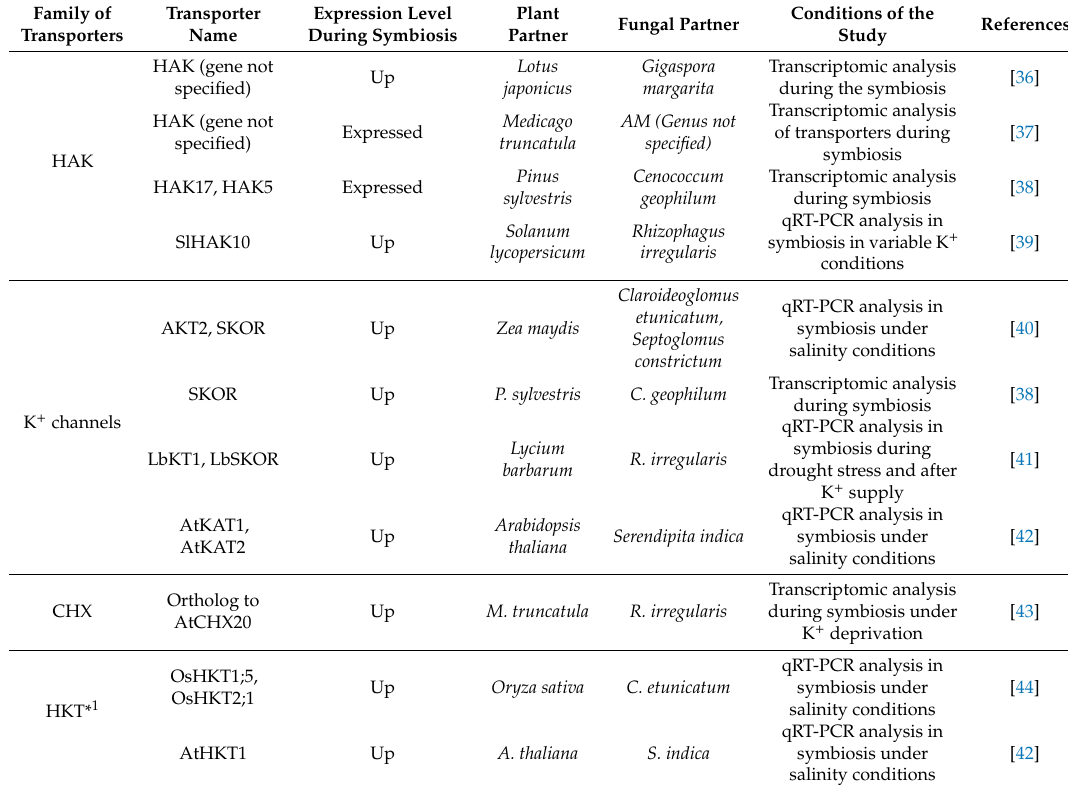
Table 1. K + plant transporters regulated during the symbiosis with the